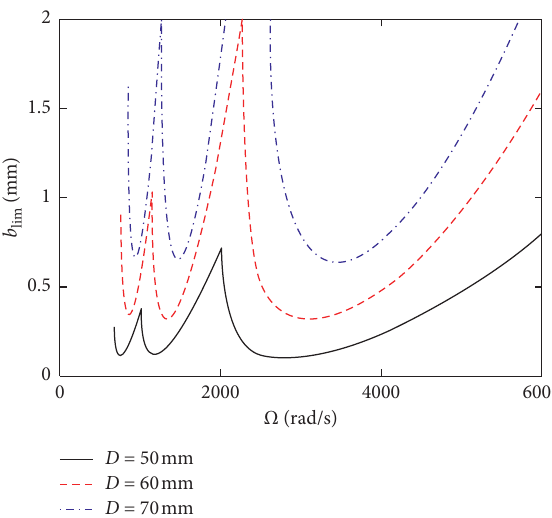
Figure 6: Effect of the diameter of the cutting bar.